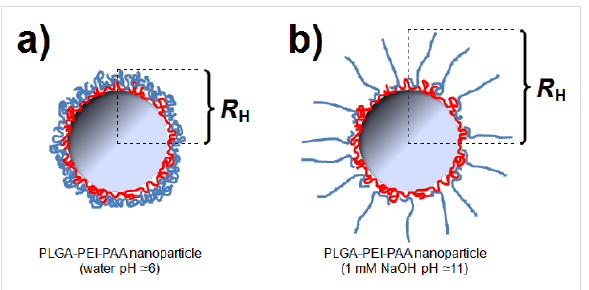
Figure 1: Sketch of terminating layer conformation for PLGA-PEI-PAA nanoparticles prepared at pH 3 in a) ultrapure water (pH approx. 6) and b) in NaOH (pH approx. 11), where PAA is fully